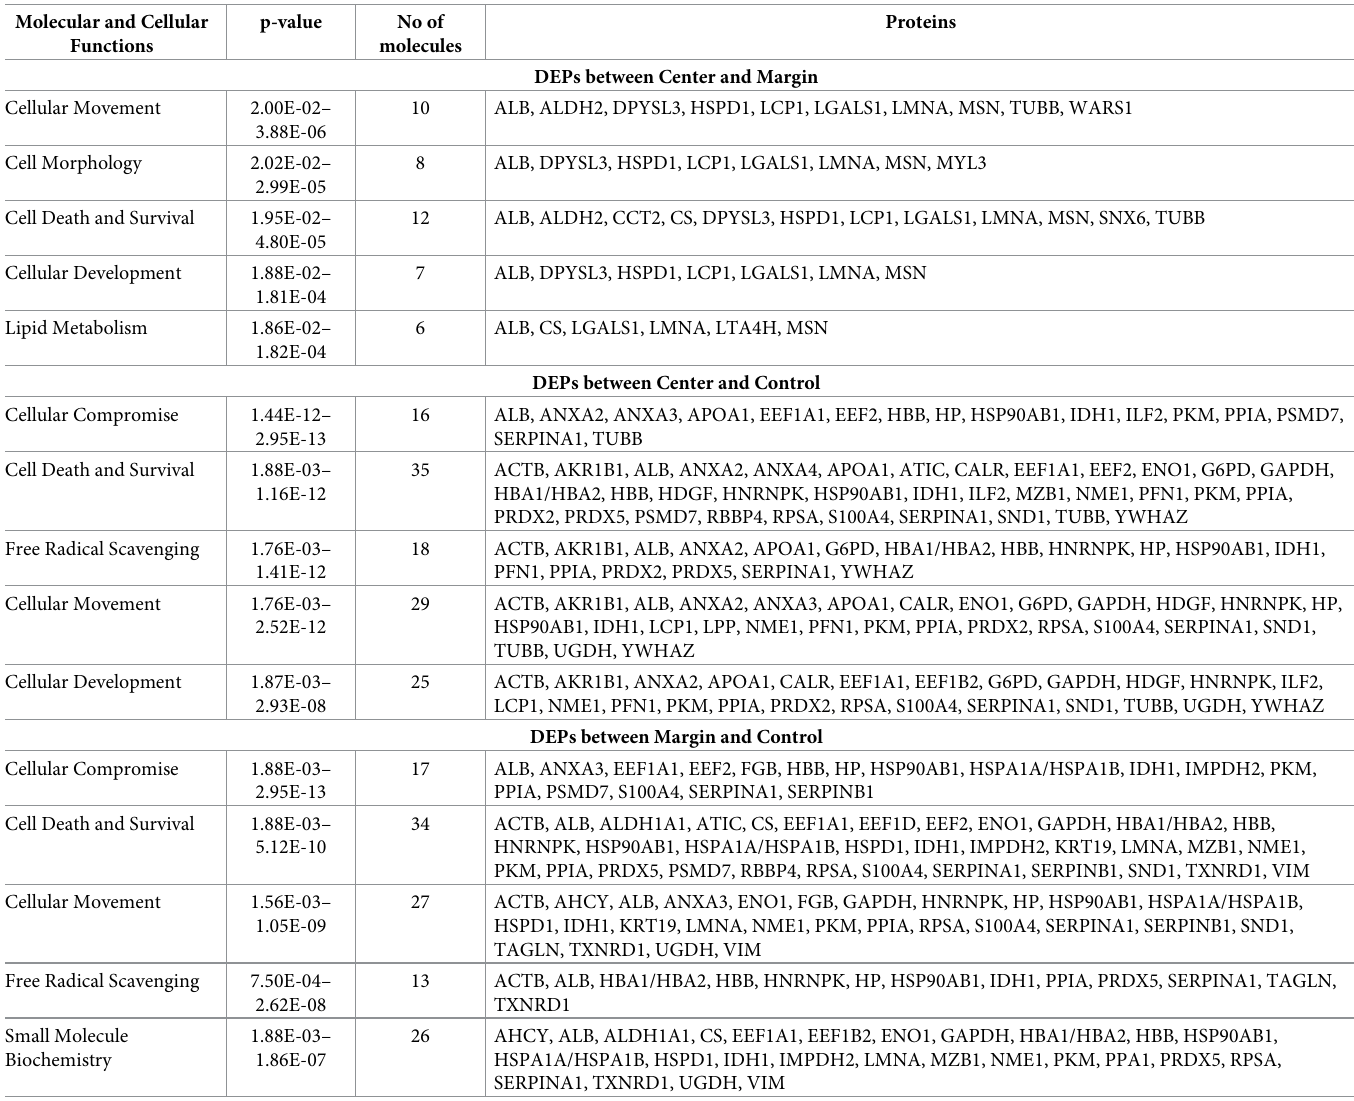
Table 5. Molecular and cellular functions of differentially expressed proteins (DEPs) in ADC